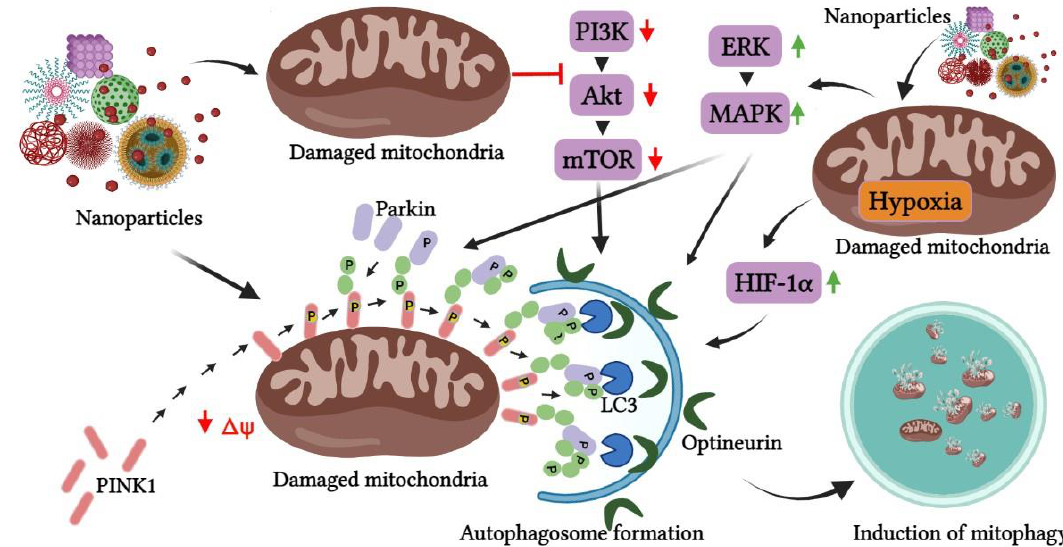
Figure 4. Crosstalk between different signaling pathways in nanoparticle-induced mitophagy. The involvement of nanoparticles in the induction of mitophagy is regulated mainly by PINK1/Parkin pathway with the involvement of additional pathways such as PI3/Akt/mTOR, ERK/MAPK and HIF- 1α. (PI3K— phosphatidylinositol 3-kinase, Akt — protein kinase B, mTOR — mammalian target of rapamycin, ERK — extracellular signal-regulated kinase, MAPK — mitogen-activated protein kinase, HIF- 1α— hypoxia-inducible factor 1 alpha, LC3 — microtubule-associated protein 1A/1B-light chain 3).